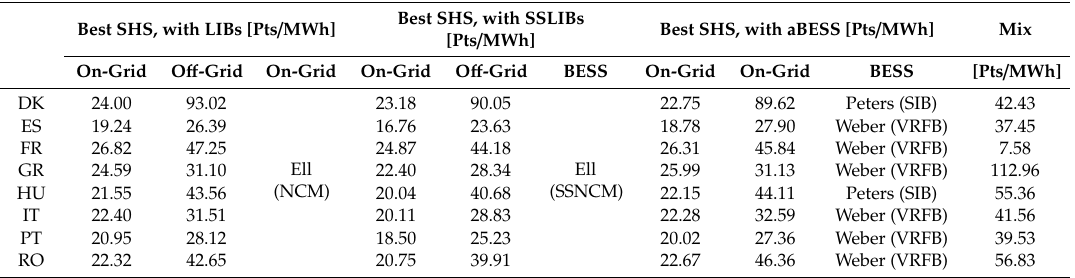
Table 11. Components contribution analysis of the most sustainable SHSs by categories and by installation sites. BESS In On-Grid O ff -Grid On-Grid O ff -Grid On-Grid